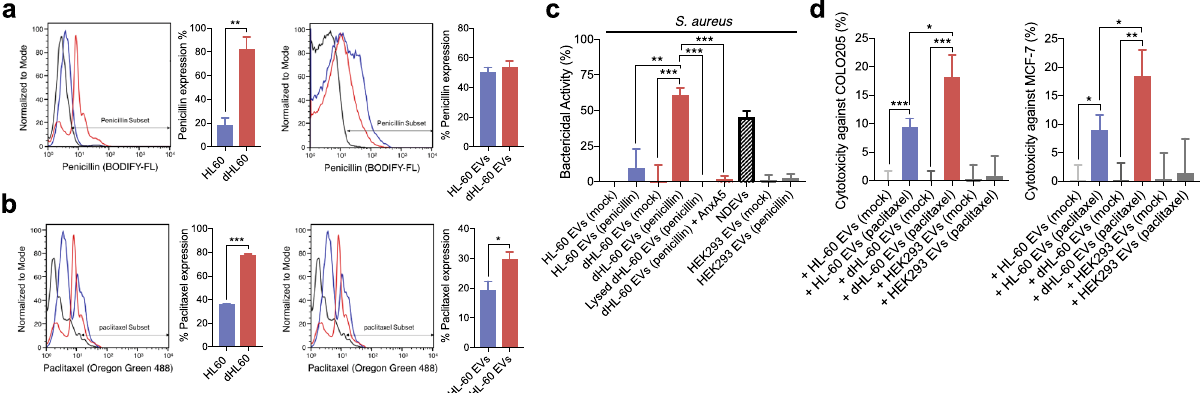
Figure 2. The delivery of penicillin and paclitaxel using dHL-60 cell-derived EVs. ( a ) Left panels, fluorescence levels of penicillin in the HL-60 and dHL-60 cells. Right panels, fluorescence levels of penicillin in the EVs derived from the HL-60 and dHL-60 cells. ( b ) Left panels, fluorescence levels of paclitaxel in the HL-60 and dHL-60 cells. Right panels, fluorescence levels of paclitaxel in EVs derived from the HL-60 and dHL-60 cells. ( c ) Bactericidal activity of penicillin-loaded EVs against S. aureus. ( d ) Cytotoxicity of paclitaxel-loaded EVs against COLO205 and MCF-7. All data represent three independent experiments; mean ± SEM. *p < 0.05; **P < 0.01; ***P <